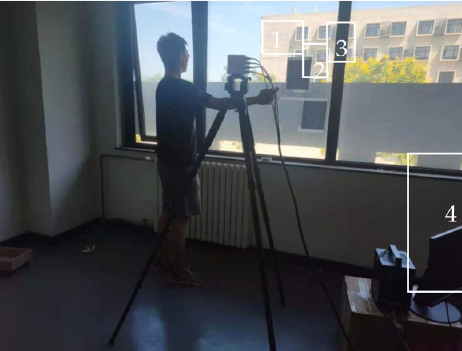
Figure 9. Flame measurement setup. ( 1 ) High-speed camera with a 35 mm lens. ( 2 ) Handheld lighter. ( 3 ) Speckle background plate. ( 4 ) Data operation and storage industrial control machine (including input and output accessories).